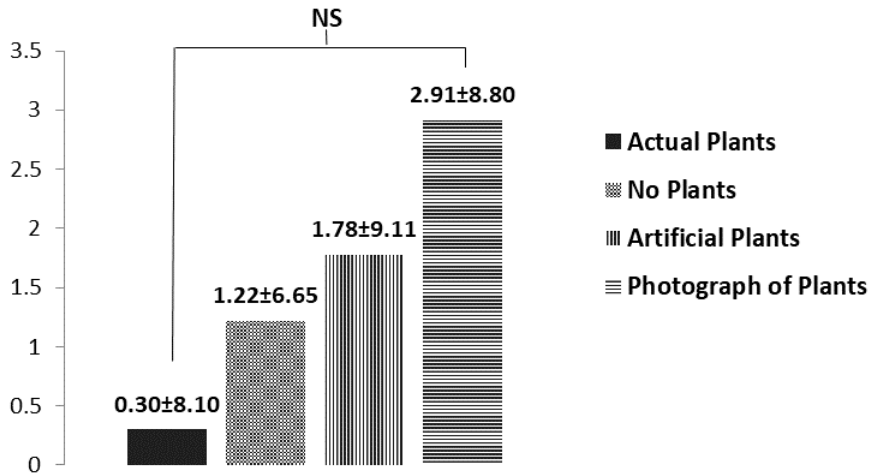
Figure 5. Comparisons of the profile of mood state (POMS) of elementary students in response to four different visual stimuli. Data are presented as means ± standard deviations. NS, non-significant.